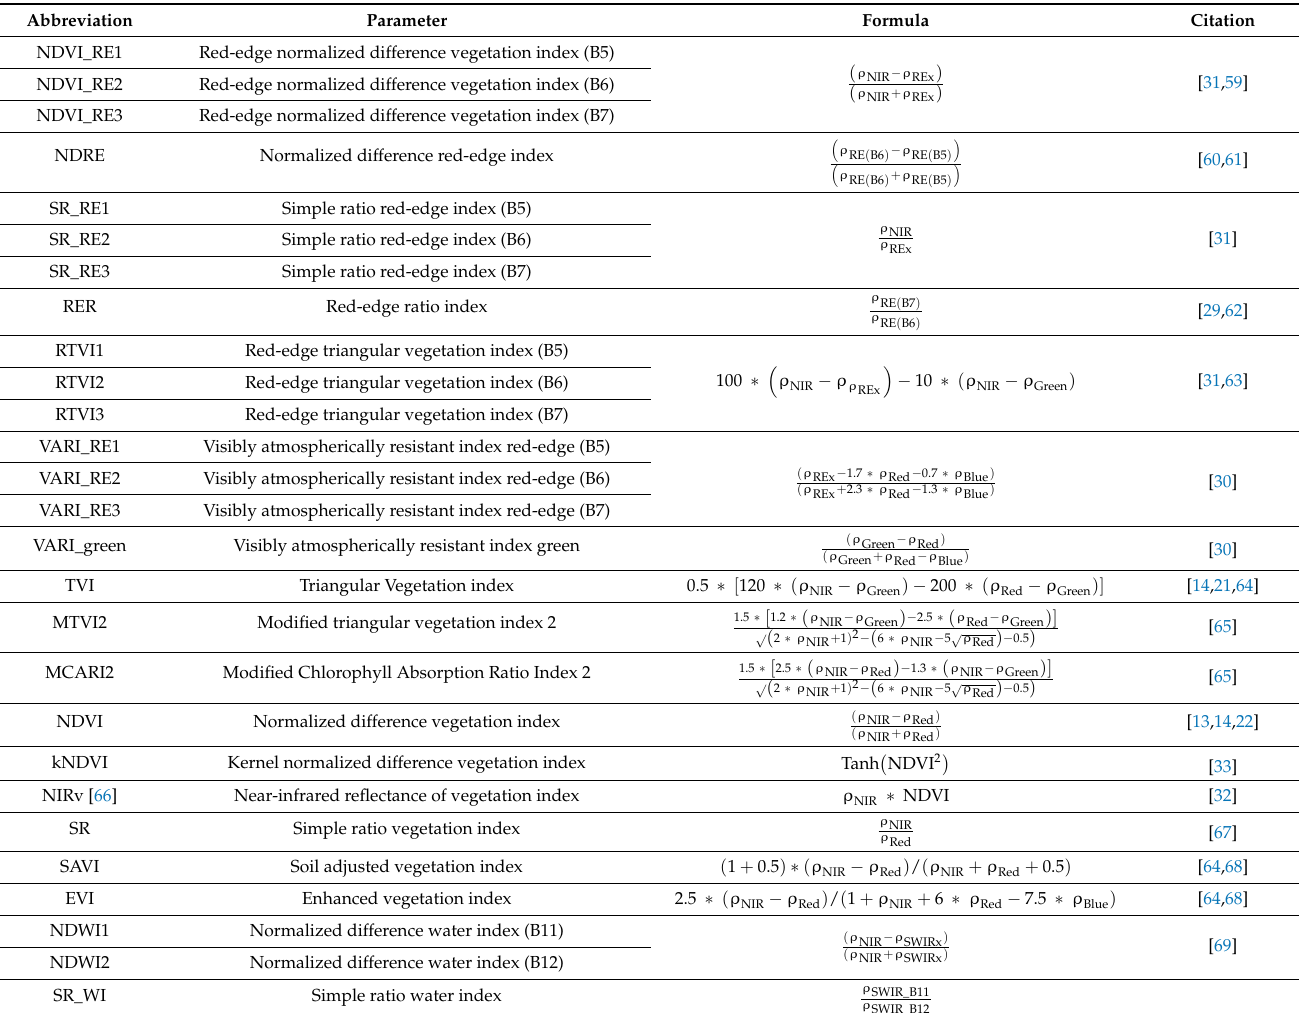
Table 1. List of optical vegetation indices (VIs) calculated from Sentinel-2 imagery where ρ indicates reflectance of a given optical band, REx indicates a red-edge optical band (which can be either band 5, 6 or 7 depending on the index variant), and SWIRx indicates a shortwave infrared band (with band 11 or 12 depending on index